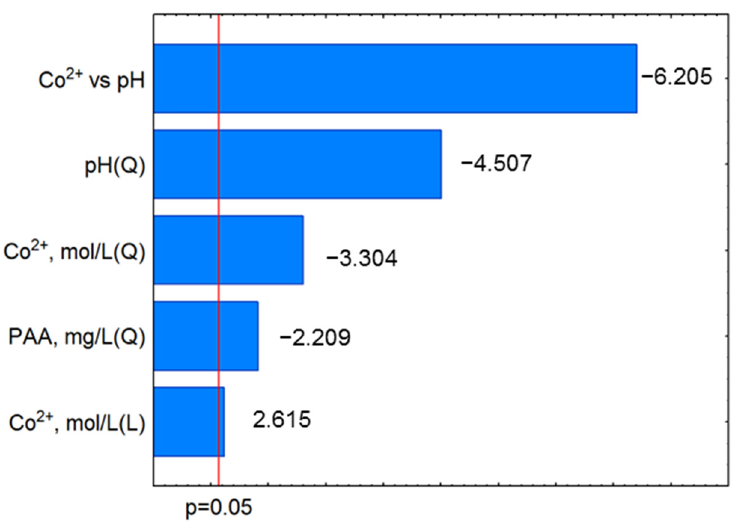
Figure 2. Absolute values of the standardized effects of UV-326 degradation in Co 2+ /PAA process.